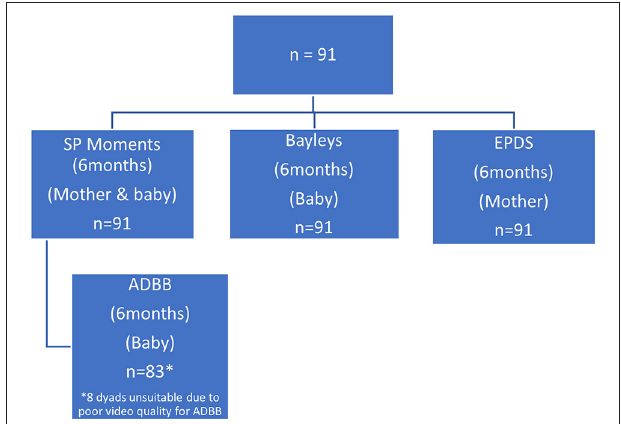
FIGURE 1 | Flow chart of Mother—Baby assessments at 6 months.